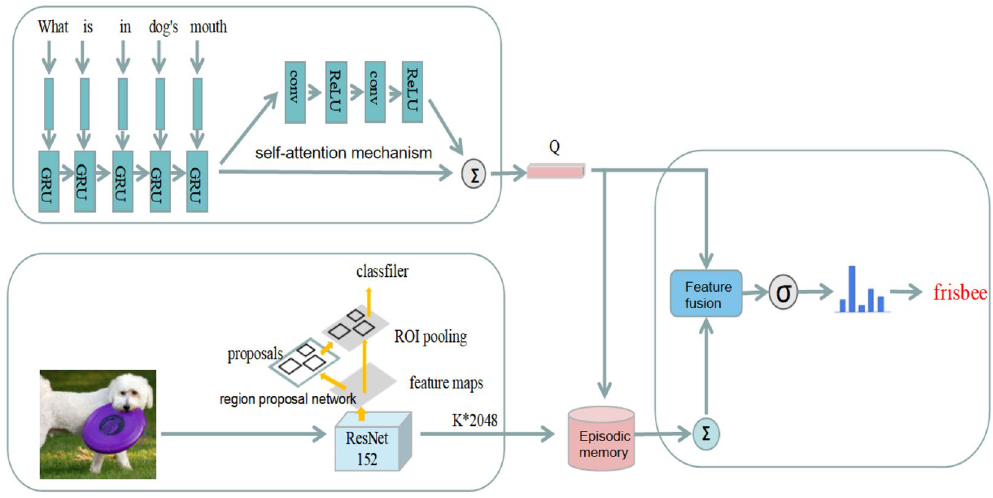
Figure 3. Overall framework of DMN-MA